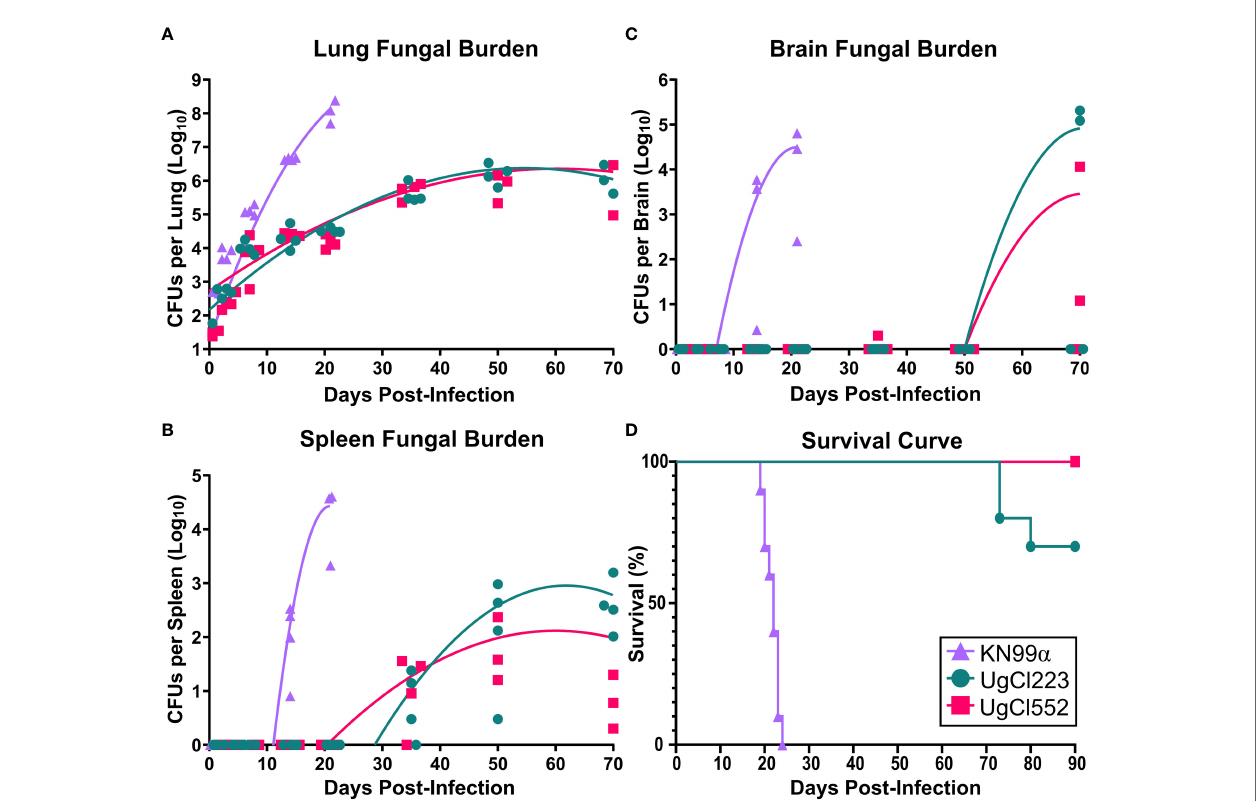
FIGURE 1 | UgCl223 and UgCl552 infections had low fungal burdens and minimal mortality. C57BL/6 mice were intranasally infected with C neoformans strains KN99 a (triangle), UgCl223 (circle), or UgCl552 (square). (A – C) UgCl223 and UgCl552 infections were characterized by low fungal burdens. (A) Lungs, (B) spleen, and (C) brain were harvested, homogenized, and plated for colony forming units (CFUs) at 0-, 3-, 7-, 14-, 21-, 35-, 50-, and 70-days post-infection. No animals selected for timepoints succumbed to the infection. No organs were collected for CFU analysis for KN99 a infection at 35-, 50-, and 70-days post-infection because all mice succumbed to infection prior to these timepoints. Trendlines were obtained using least squares regression with Gaussian distribution. n = 3-4 mice per timepoint per strain. (D) The majority of mice infected with UgCl223 and UgCl552 remained healthy. Mice were monitored for signs of morbidity for 90 days and sacri fi ced at natural endpoint (20% total weight loss; 1 g/day weight loss for 2 consecutive days; or neurological symptoms including loss of sternal recumbency, partial paralysis, seizure, convulsion, or coma). n = 9-10 mice per